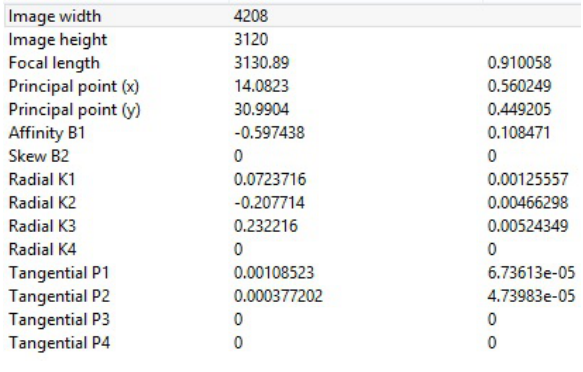
Figure 4. The position of objects on topographical map scale